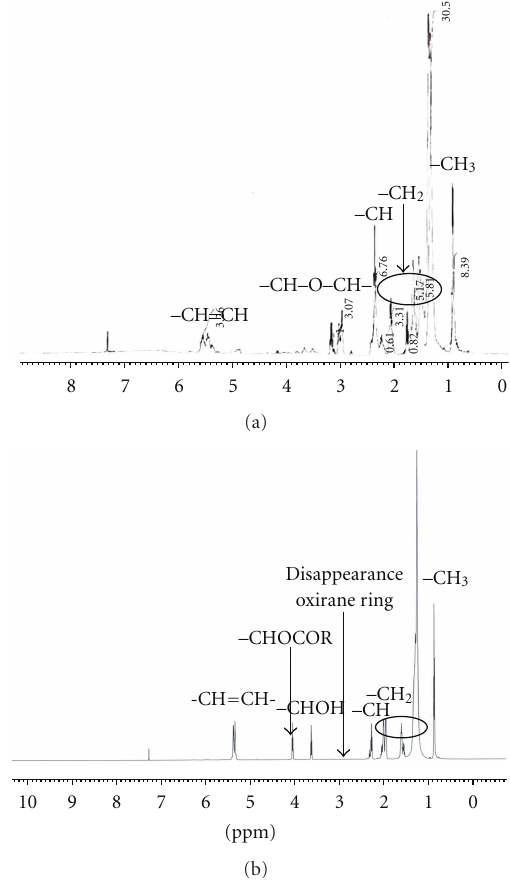
Figure 6: 1 H NMR spectrum of MEOA (a) and HYOOA (b).